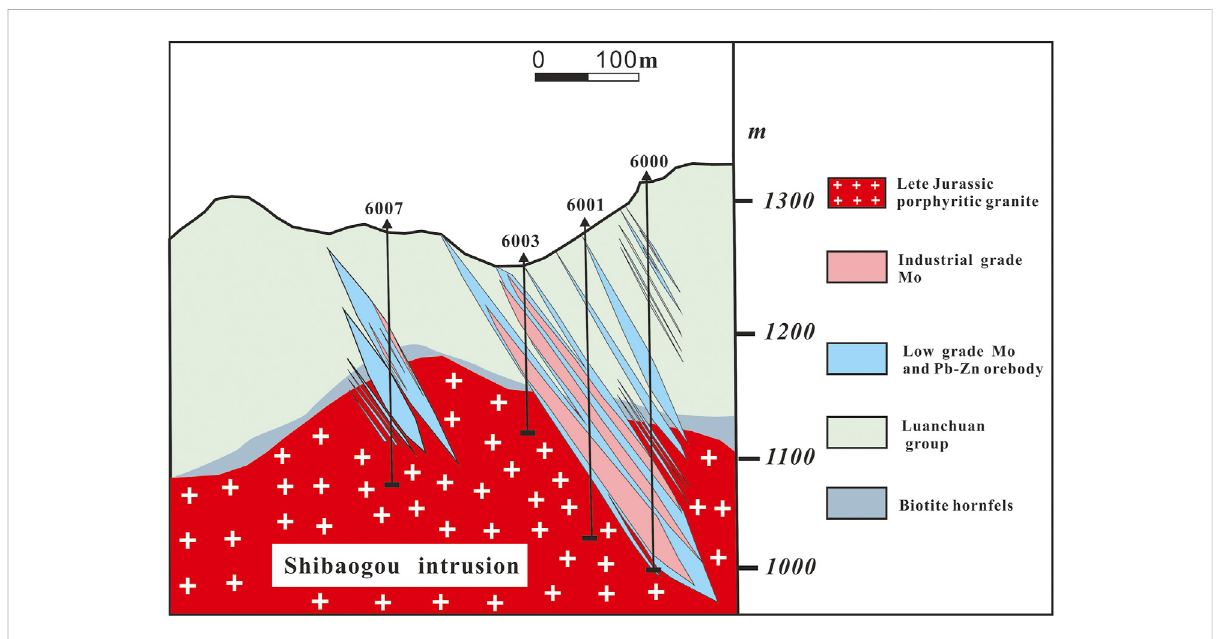
FIGURE 3 Geological map of the Shibaogou Mo – Pb – Zn deposit geologic cross section showing the spatial relationship among strata, intrusion, alteration, and ore